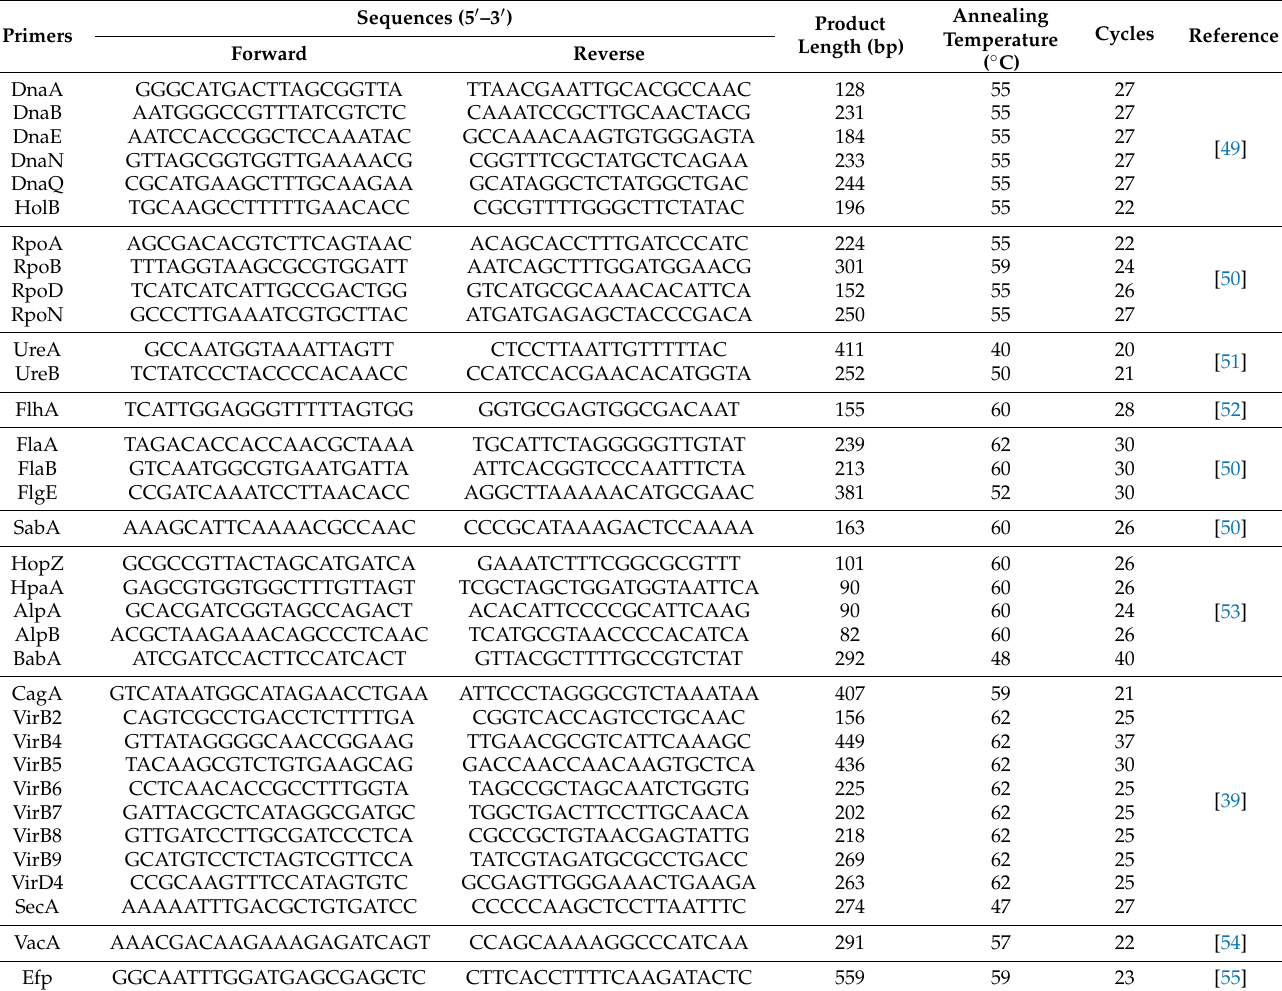
Table 2. List of primer sequences and PCR conditions used for RT-PCR.